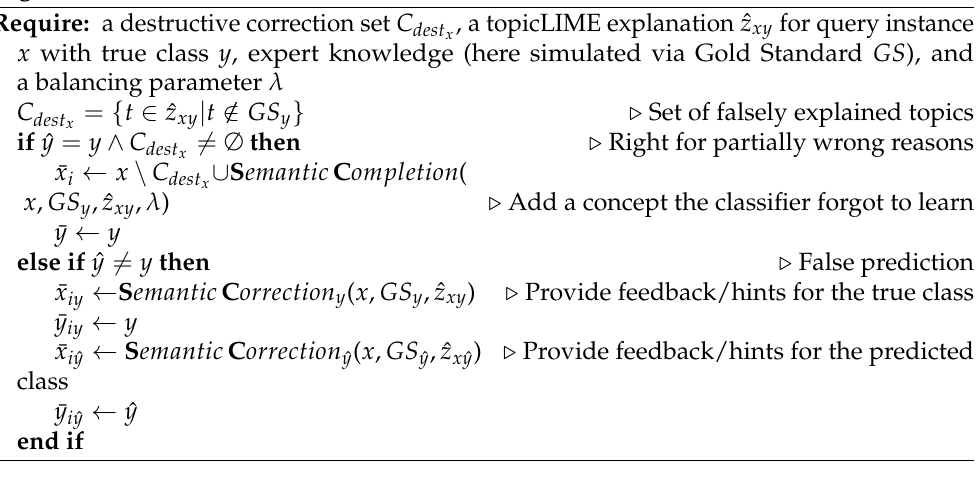
Algorithm 2 SemanticPush